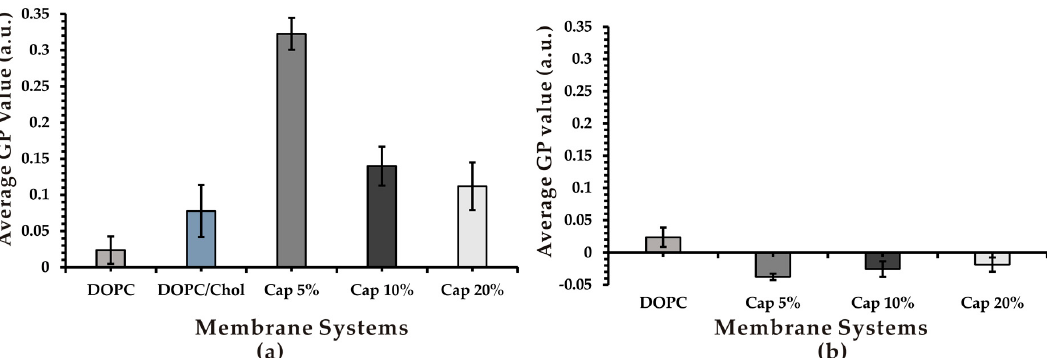
Figure 3. Generalized polarization values as membrane fluidity measured using a laurdan probe. ( a ) DOPC/Chol/Cap and ( b ) DOPC/Cap vesicles at different concentrations of capsaicin. a.u.: Arbitrary units.